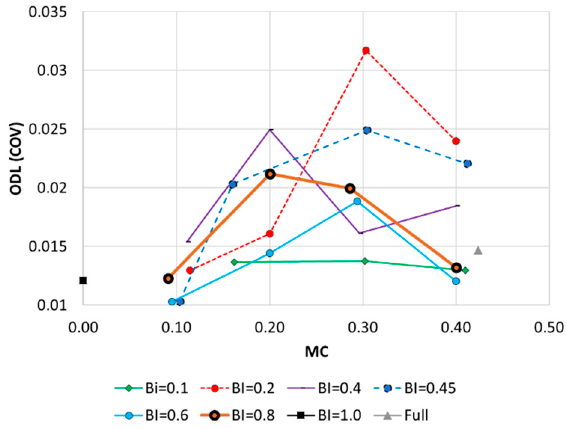
Figure 4. ODLs and MCs of the 25 networks grouped by BI values (B-City network).